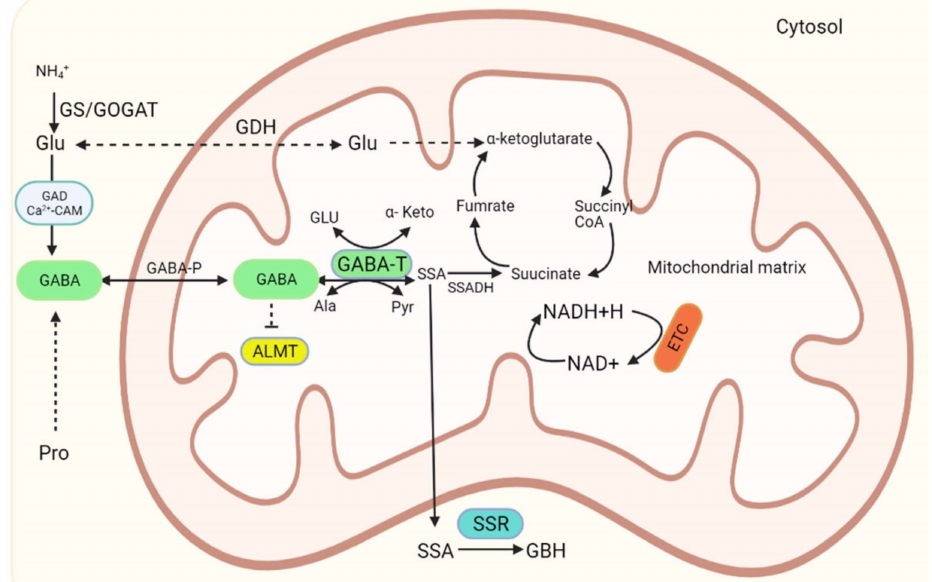
Figure 1. GABA biosynthesis in plants mediated by GABA shunts as adapted from Ramos-Ruiz et al. (2019) [18]. Abbreviations: GAD, glutamate decarboxylase; GABA-P, GABA permease; GABA-T, GABA transaminase; ALMT, aluminum-activated malate transporter; Glu, glutamate; Ala, alanine; Pyr, pyruvate; SSADH, succinic semialdehyde dehydrogenase; ETC, electron transport chain; SSR, succinic semialdehyde reductase; SSA, succinic semialdehyde; GBH, gamma-hydroxybutyric